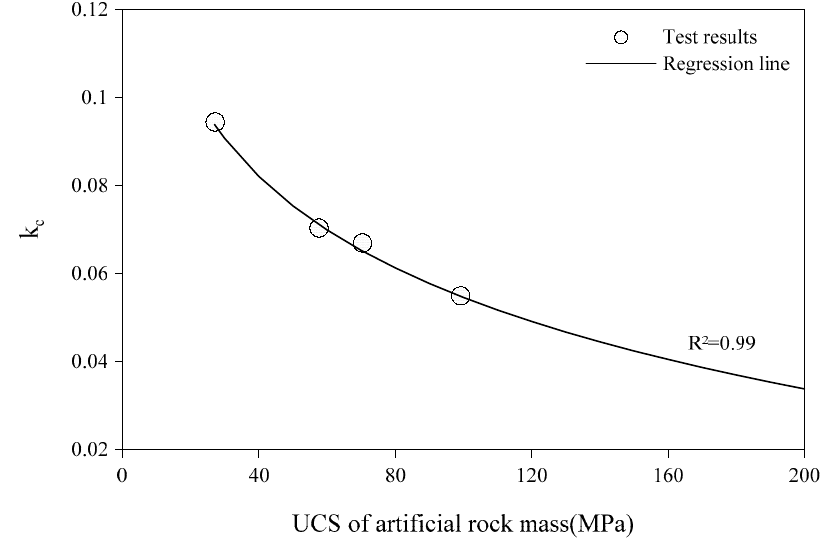
Figure 11. k c values according to UCS of artificial rock mass.